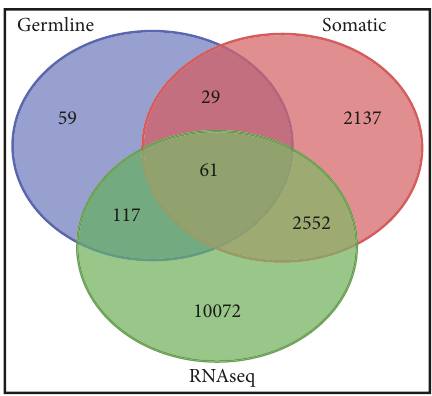
Figure2:Venndiagramshowingdifferentiallyandnondifferentially expressed germline and somatic mutated and nonmutated genes. Middle intersections show 61 genes containing both germline and somatic mutations and are also significantly expressed with RNA-seq dataset. Germline indicates genes with germline genetic susceptibility variants from GWAS. Somatic indicates genes with somatic mutations from TCGA. RNA-seq indicates differentially expressed genes evaluated using TCGA gene expression